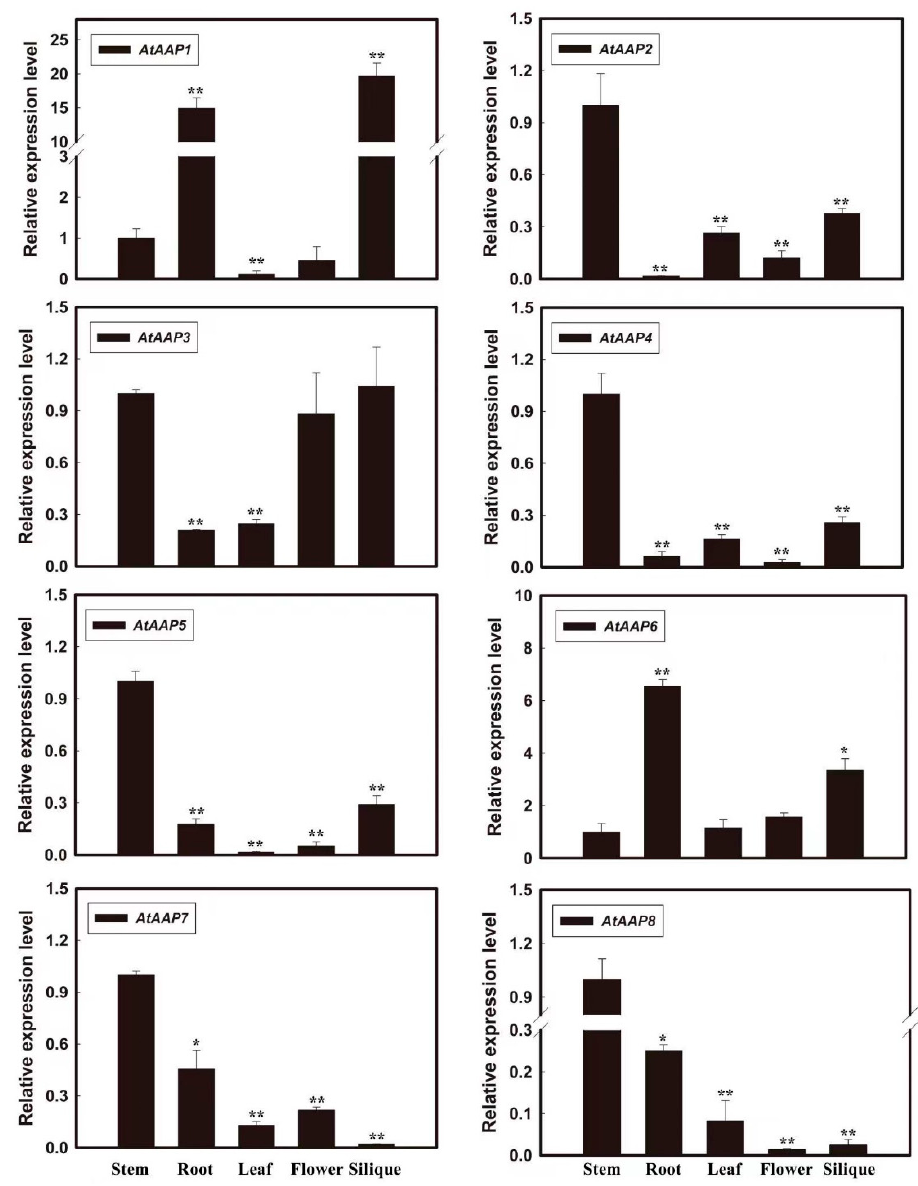
Figure 4. Relative expression patterns of eight AtAAP genes in different tissues of transgenic Arabidopsis thaliana with overexpression of AtAAP1 based on qRT-PCR analysis using actin gene as the internal reference gene. Symbols “*” and “**” indicate significant differences in comparison to stems at p values of 0.05 and 0.01, respectively.